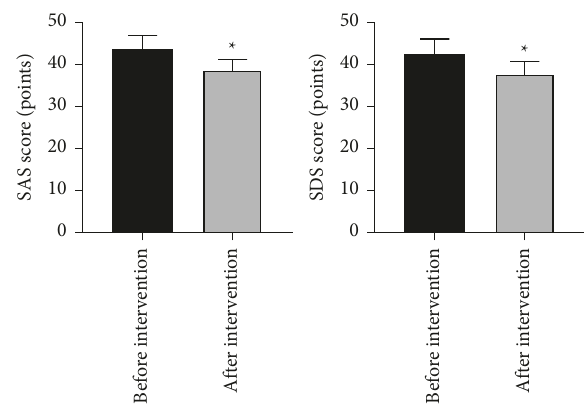
Figure 1: Comparison of psychological state before and after intervention compared with before intervention, ∗ P < 0 . 05. Comparison of work stress before and after